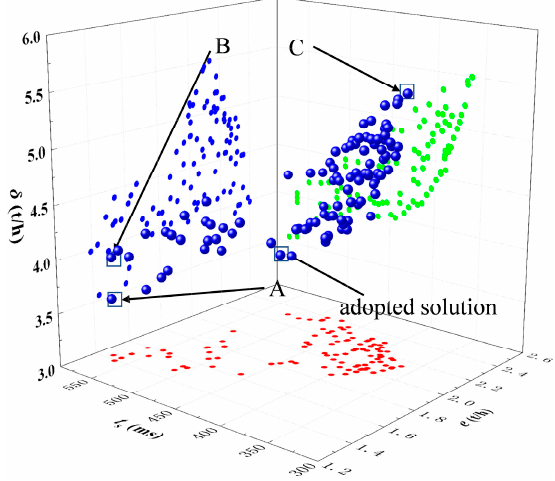
Figure 21. Optimal solution set of NSGA-II algorithm.